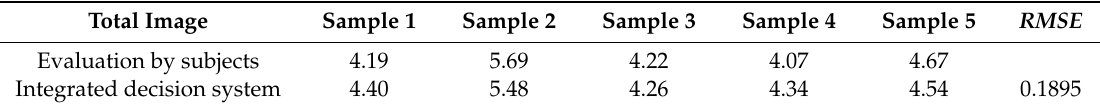
Table 7. RMSE result of the integrated decision system of train seat total image